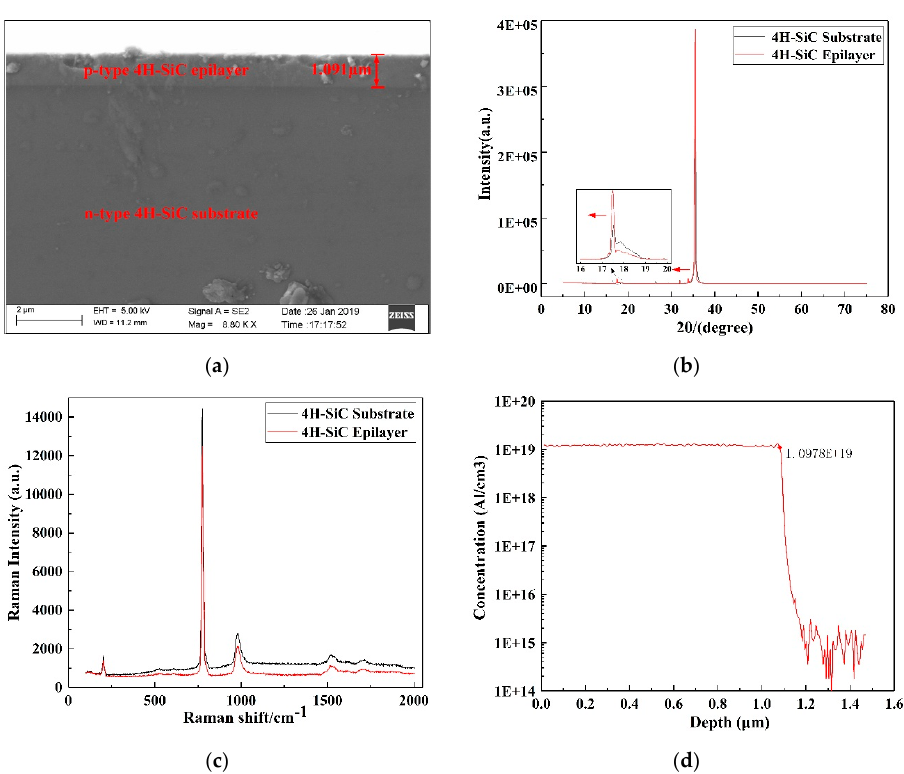
Figure 2. ( a ) Cross-sectional view of the p-type 4H-SiC epilayer on the n-type 4H-SiC substrate at 5000 times magnification. ( b ) X-ray diffraction (XRD) spectrum of the 4H-SiC epitaxial layer and substrate. ( c ) Raman spectra of the 4H-SiC epitaxial layer and substrate. ( d ) Secondary ion mass spectrometry (SIMS) profile of the 4H-SiC epitaxial layer.